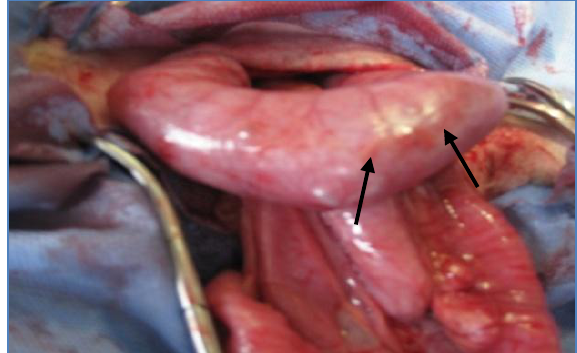
Figure, 4: Gross appearance of colon, shows the colonic incisional sites (thick, thin arrows) with no adhesions formation (grade, zero), 30 th days post-operation in group